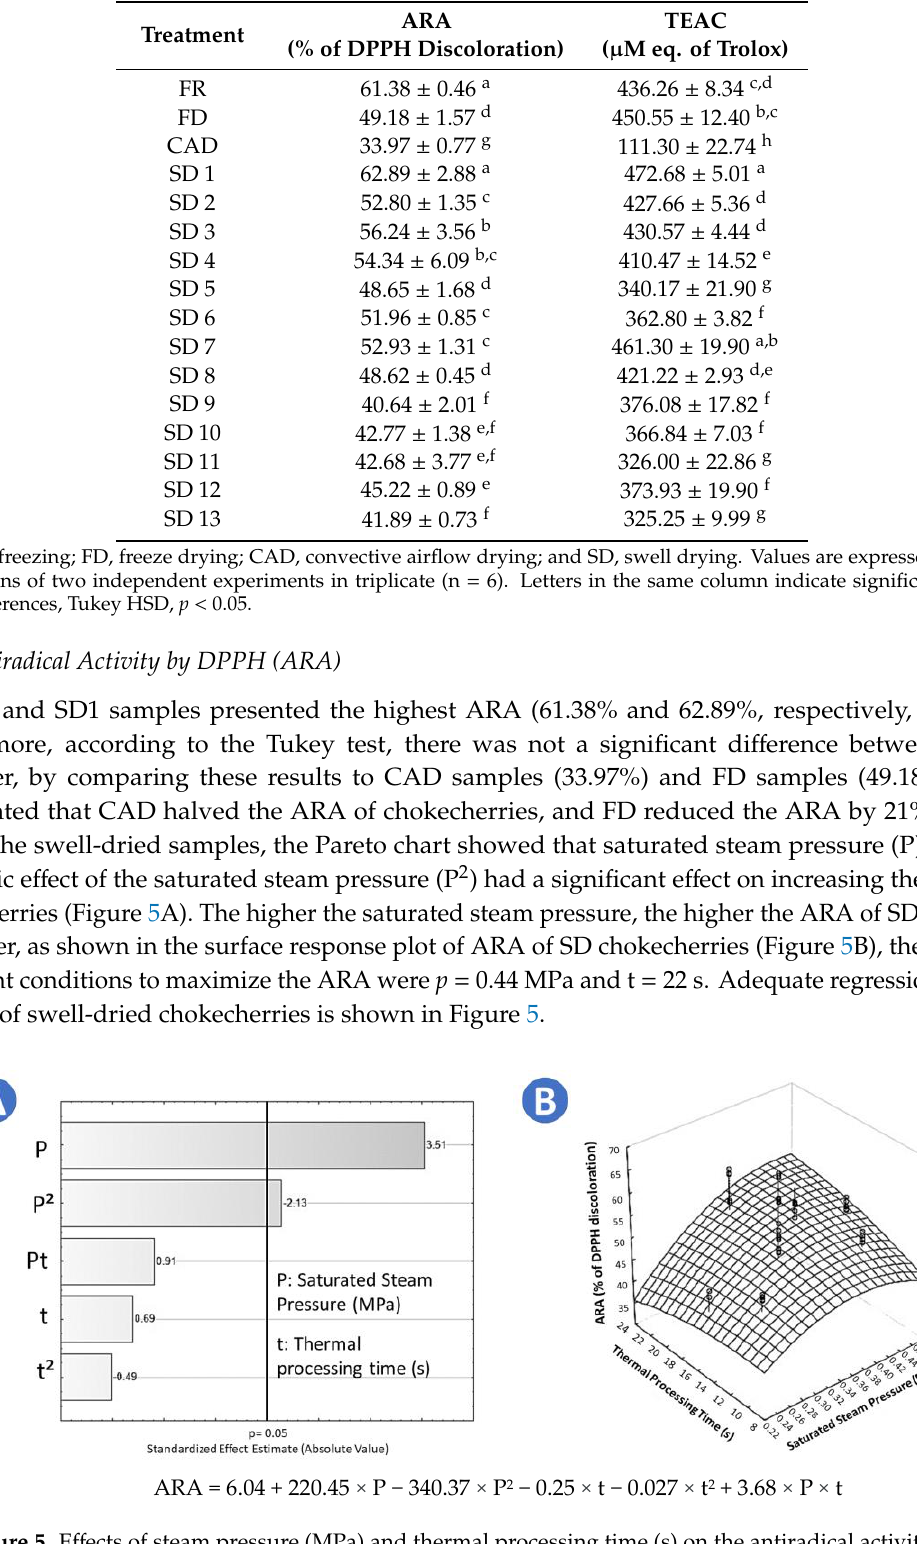
Table 3. Antioxidant capacity of treated chokecherries.